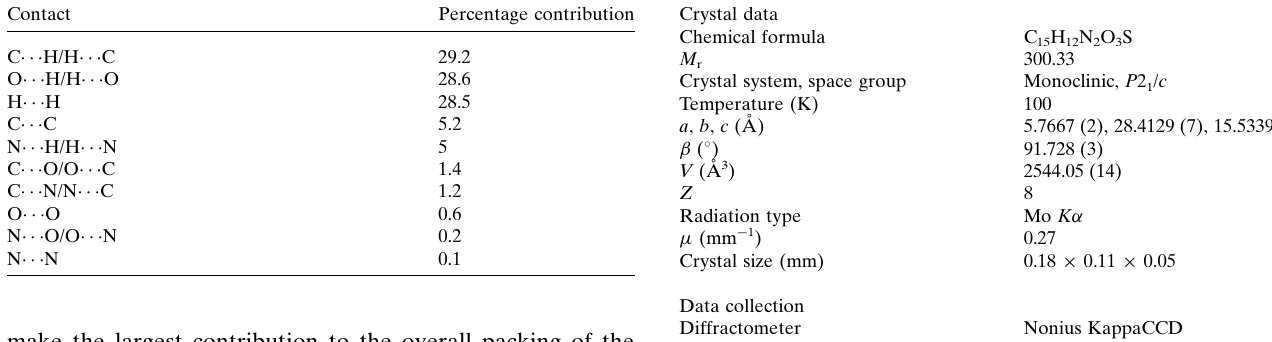
Table 3 Experimental details. Crystal data Chemical formula